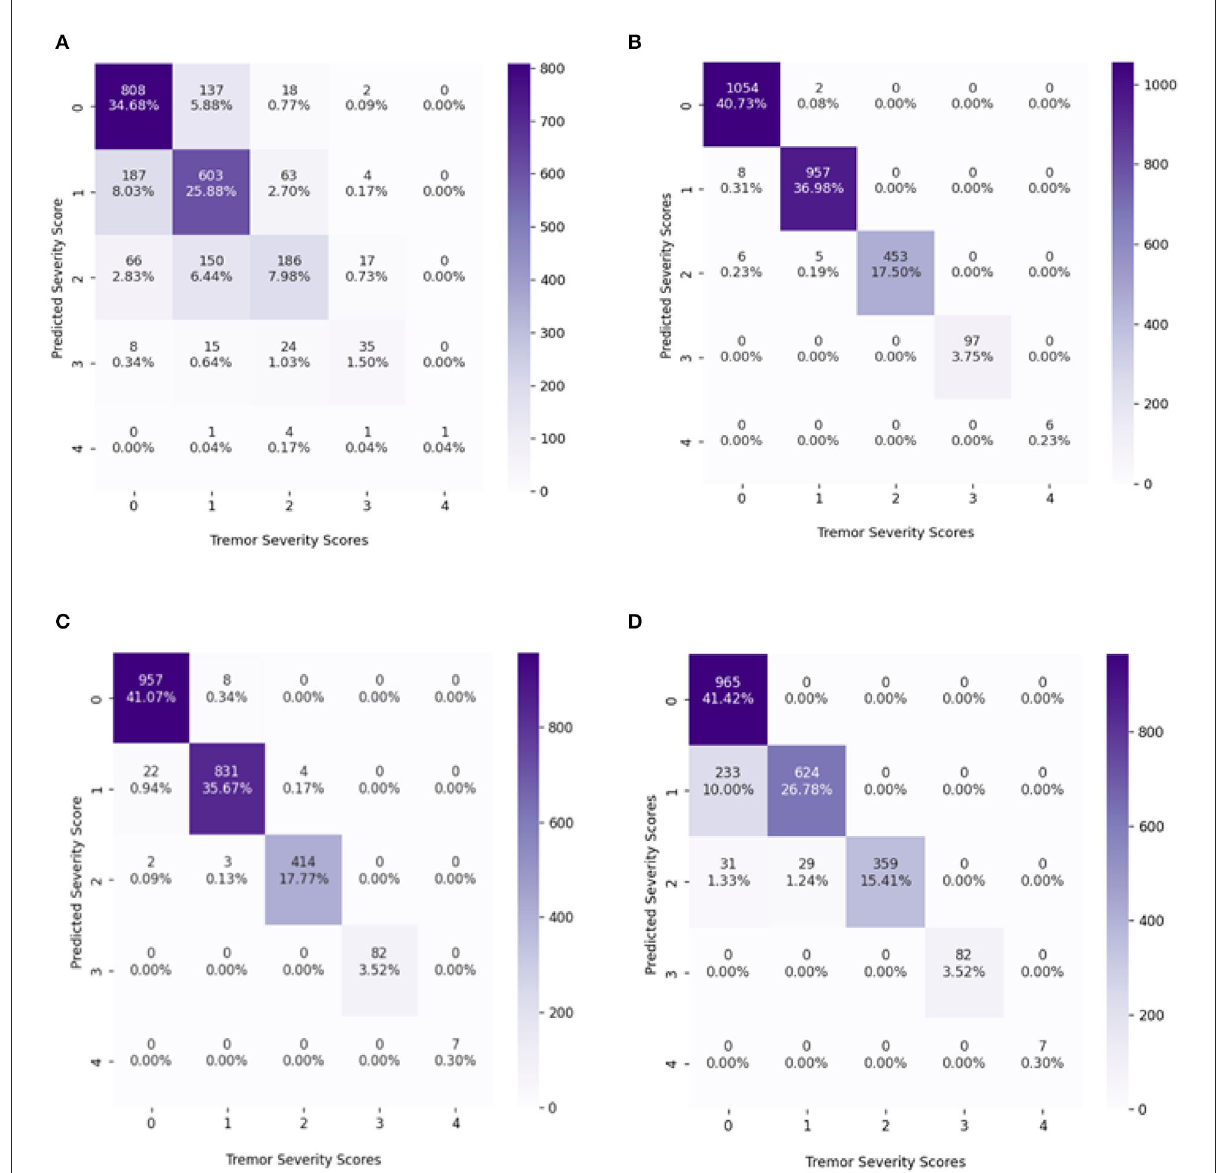
FIGURE5 The confusion matrix (CM) of the classifiers with maximum accuracy, (A) CM of the XGBoost classifier without resampling, (B) CM of the XGBoost classifier with a random over-sampling method., (C) CM of Decision tree classifier with a random over-sampling method., (D) CM of KNN classifier with a random over-sampling